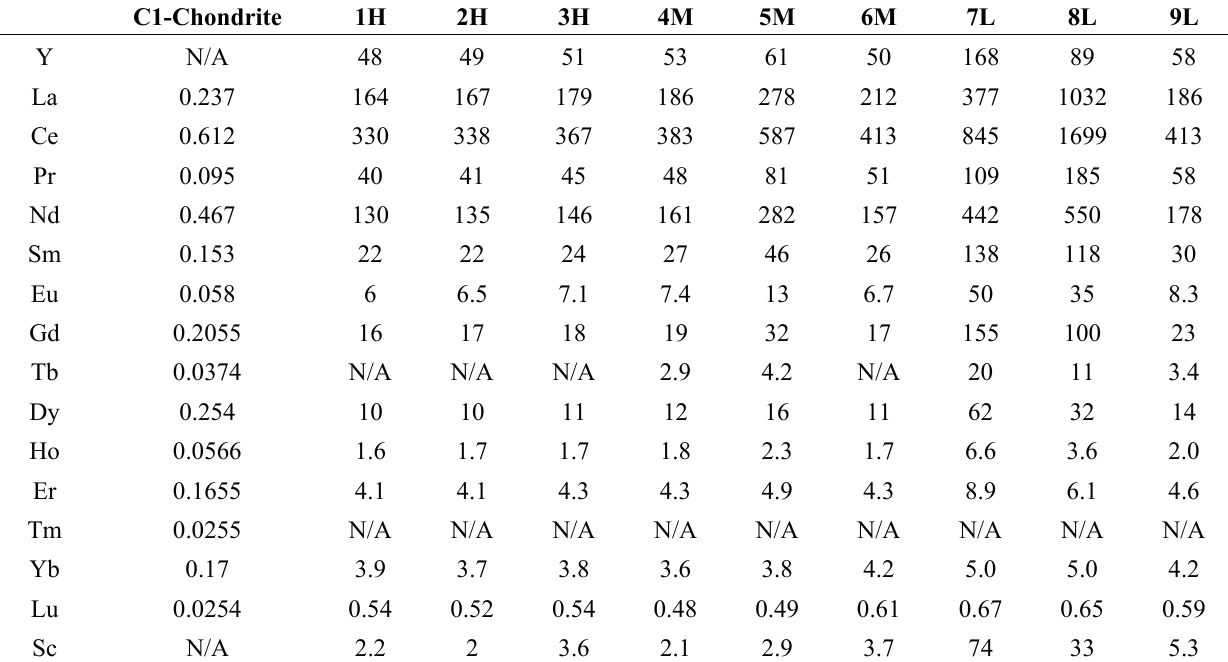
Table 2. Concentrations of REEs in the nine ground samples (ppm) and the C1-chondrite normalizing factors. Cerium (Ce) and gadolinium (Gd) show the differences between the two classes of rocks. Cerium represents the distribution of the LREE and gadolinium represents enrichment within the MREEs in samples 7L and 8L. N/A are either values that are not provided in the cited literature or are erroneous ICP-AES measurements.